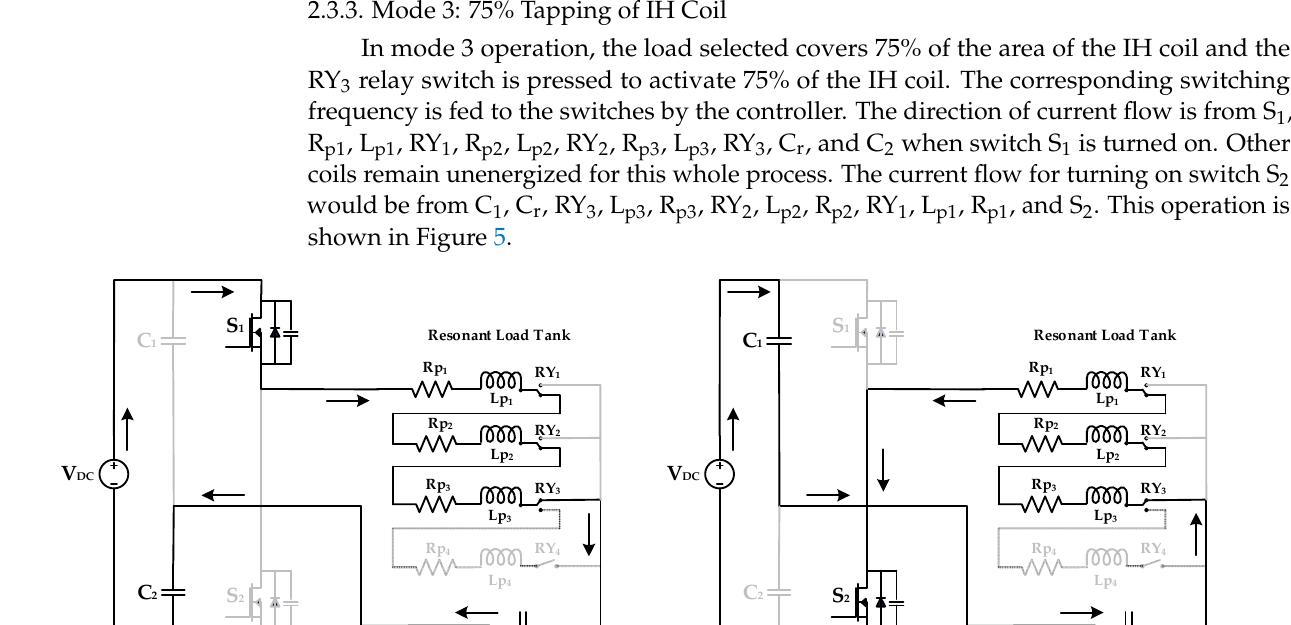
Figure 4. Circuit diagram of Mode 2: ( a ) Switch S 1 in ON state; ( b ) Switch S 2 in ON state.